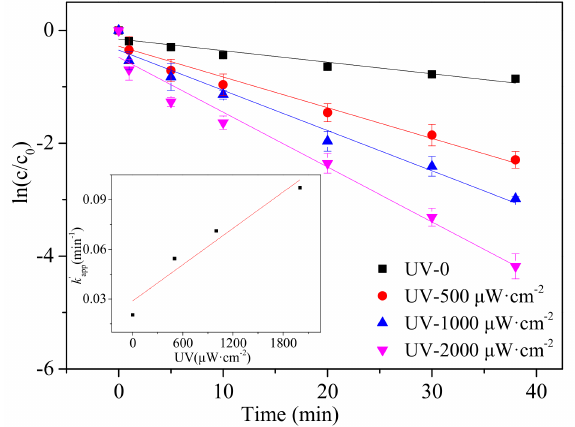
Figure 3. E ff ect of UV light intensity on AML degradation by the UV / chlorine process ([AML] 0 = 10 µ M, [chlorine] 0 = 20 µ M, pH =